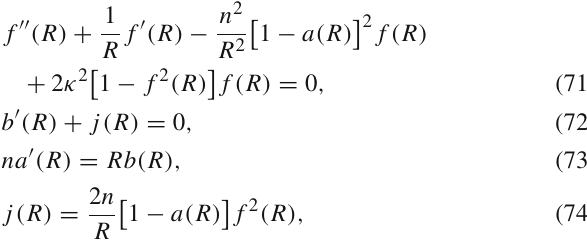
and J from the numerical solutions f ( R ) and a ( R ) by